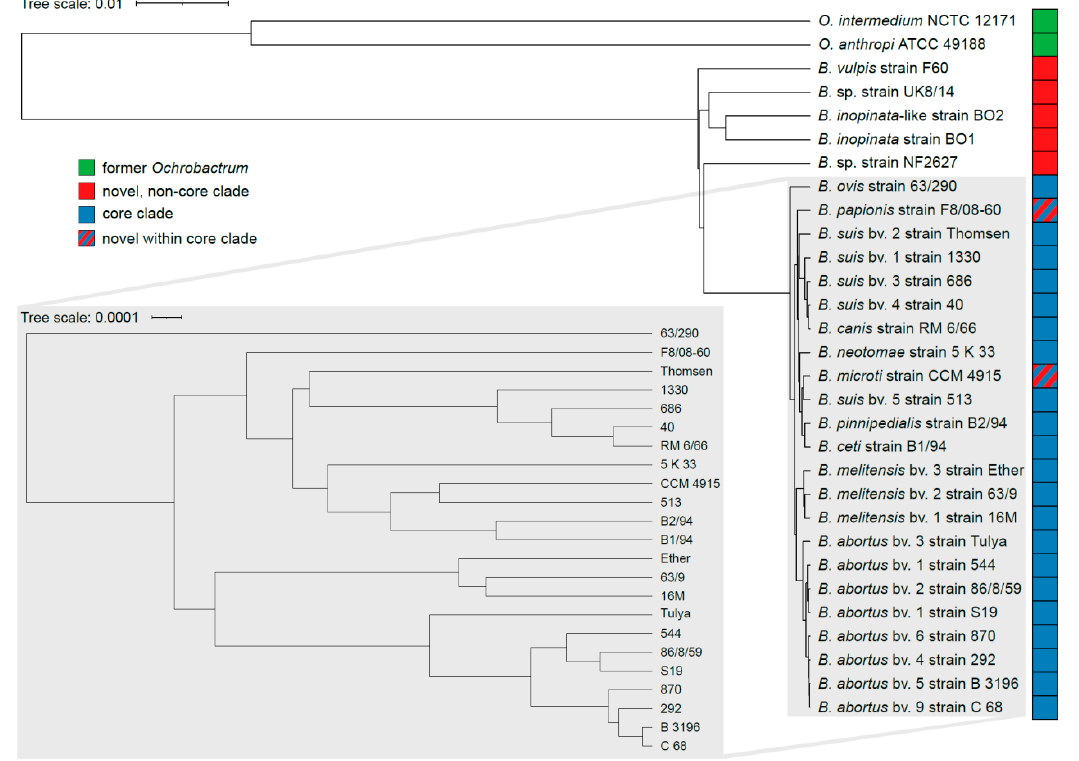
Figure 1. Phylogenetic tree of the genus Brucella . Genome assemblies of Brucella strains, including all core and novel type strains, as well as two former Ochrobactrum type strains, were used. Pairwise average nucleotide identities were calculated with fastANI (v1.32) [5]. Hierarchical clustering was conducted using the unweighted pair group with arithmetic mean (UPGMA) method. The phylogenetic tree was visualized with the EMBL online tool “Interactive Tree Of Life” (iTOL v6). The colored squares indicate affiliation to Brucella groups. The gray shaded area illustrates the phylogeny of the core clade in more detail.